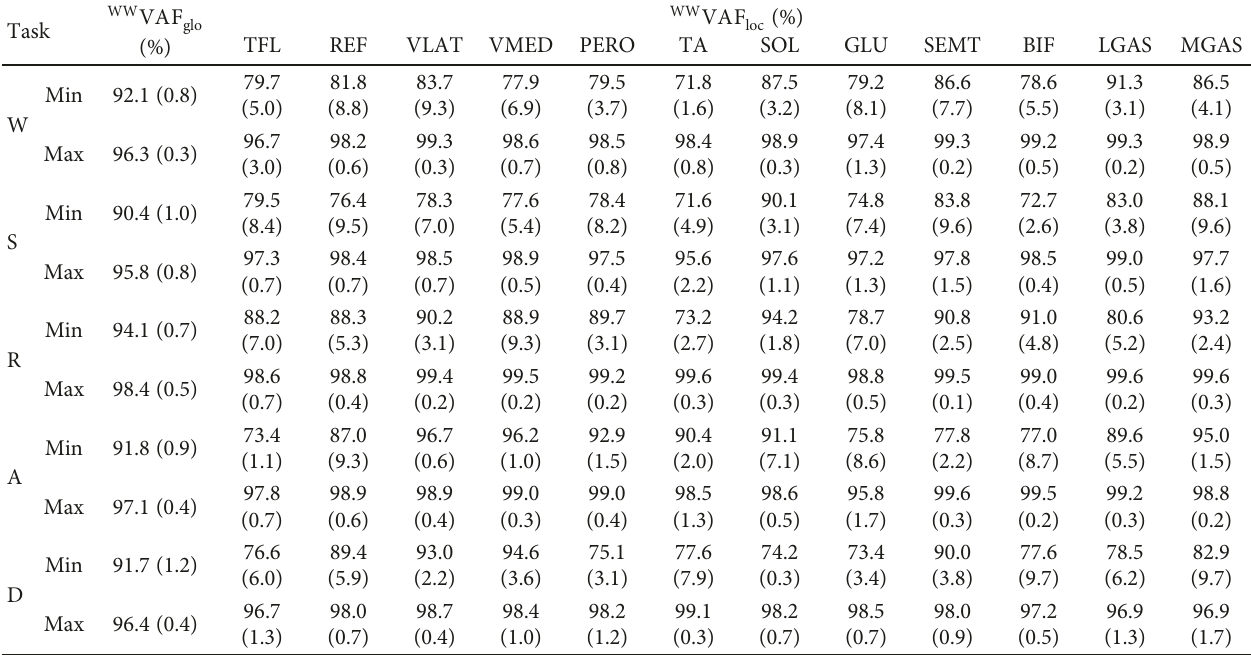
and WW VAF related to each task. glo loc WW VAF (%) loc